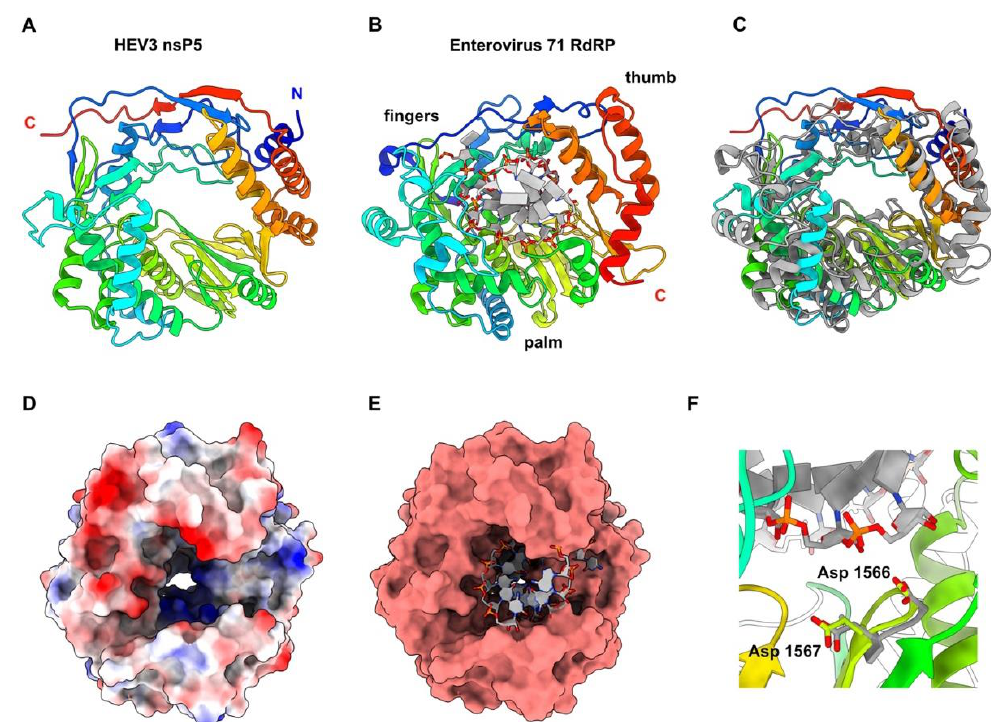
Figure 6. HEV-3 nsP5 predicted structure, the viral RdRp. ( A ) Ribbon representation of HEV-3 nsP5 predicted structure (rainbow colored). ( B ) Ribbon representation of the enterovirus71 RdRp (rainbow) in complex with dsRNA (colored by atoms, C: white; O: red; N: blue; P: orange). ( C ) Superimposition of HEV-3 nsP5 (rainbow) and the enterovius 71 RdRp (grey). ( D ) Surface representation of HEV-3 nsP5 colored by electrostatic potential. The internal tunnel is positively charged, in accordance with RNA synthesis. ( E ) Surface representation of HEV-3 nsP5 with dsRNA in the same position as in the enterovirus71 RdRP, after superimposition of both proteins onto each other (in C). ( F ) Highlight on HEV-3 nsP5 Asp 1566 and Asp 1567 and enterovirus71 RdRP catalytic residues Asp 329 and Asp 339.